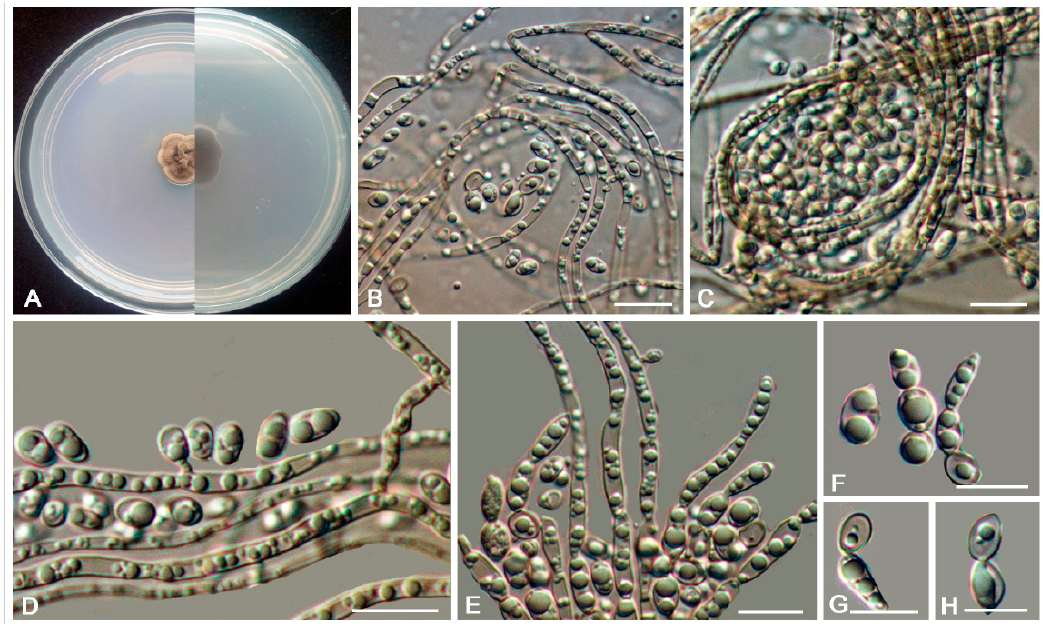
Figure 19. Exophiala cinerea (CGMCC 3.18778). ( A ) Forward (left) and reverse (right) of colony on MEA. ( B , C ) Spirally twisted hyphae. ( D ) Conidia alongside hyphae. ( E ) Conidial apparatus with conidia. ( F – H ) Conidia. Scale bars: ( B – H ) = 10 μ